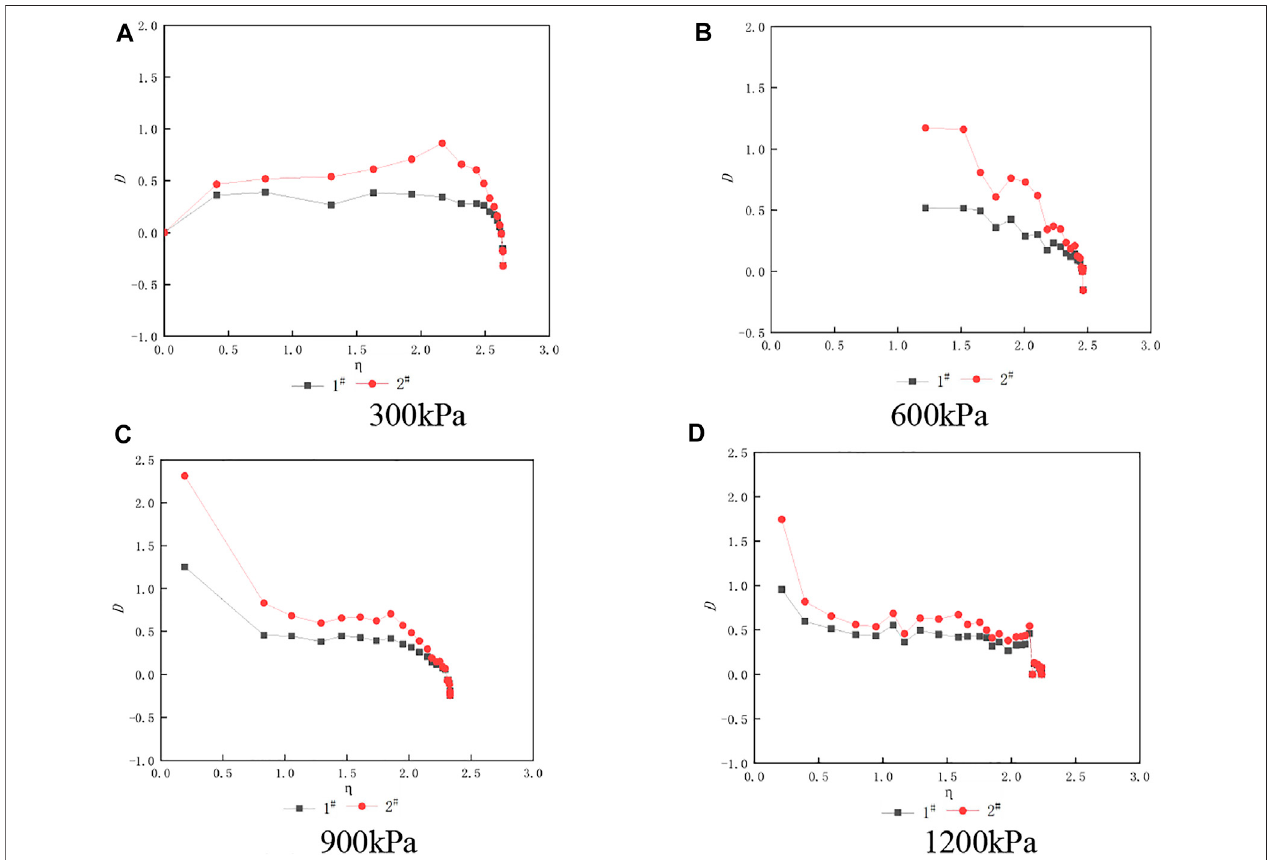
FIGURE 13 | The dilatancy ratio of LCSG material with cemented content of 100kg/m3 under different con fi ning pressures. (A) 300 kPa (B) 600 kPa (C) 900 kPa (D) 1,200 kPa.